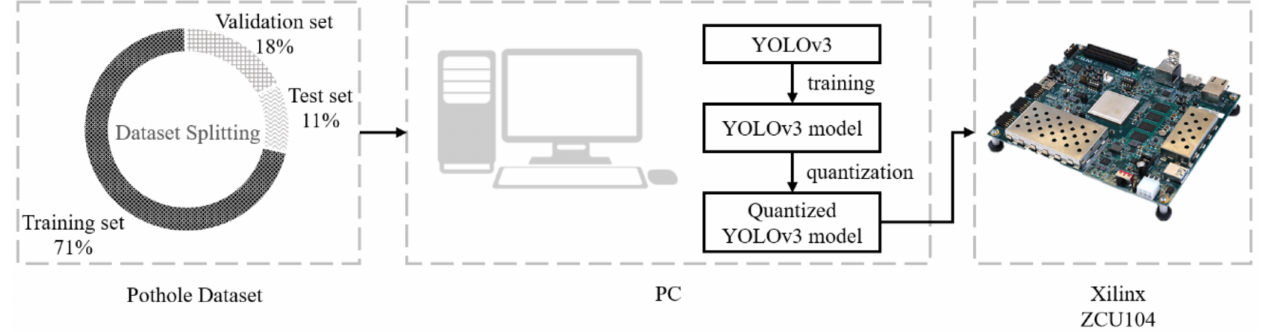
Figure 3. Model compression strategy and verification